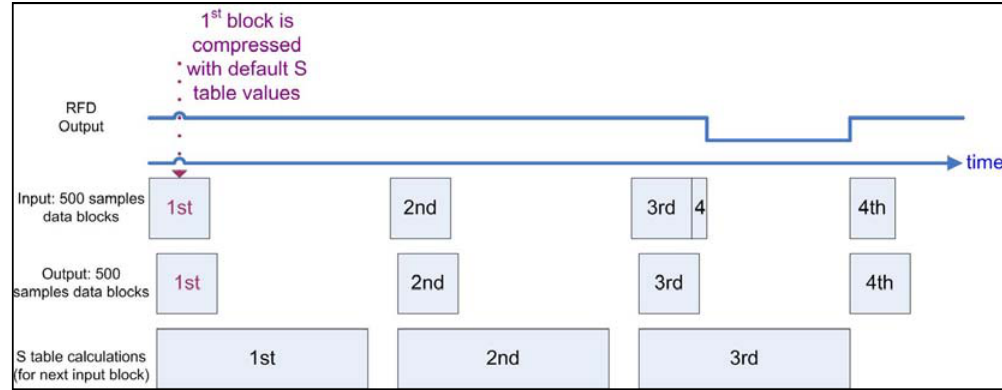
Figure 4. Compression module block data flow.